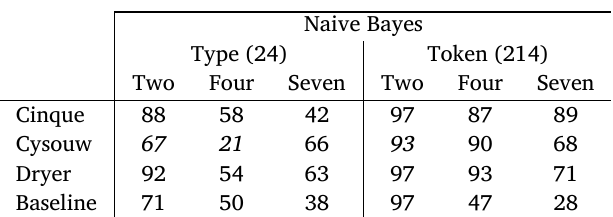
Percent (rounded accuracy) of languages or language types classified in the right frequency class. Italics indicate lower than baseline